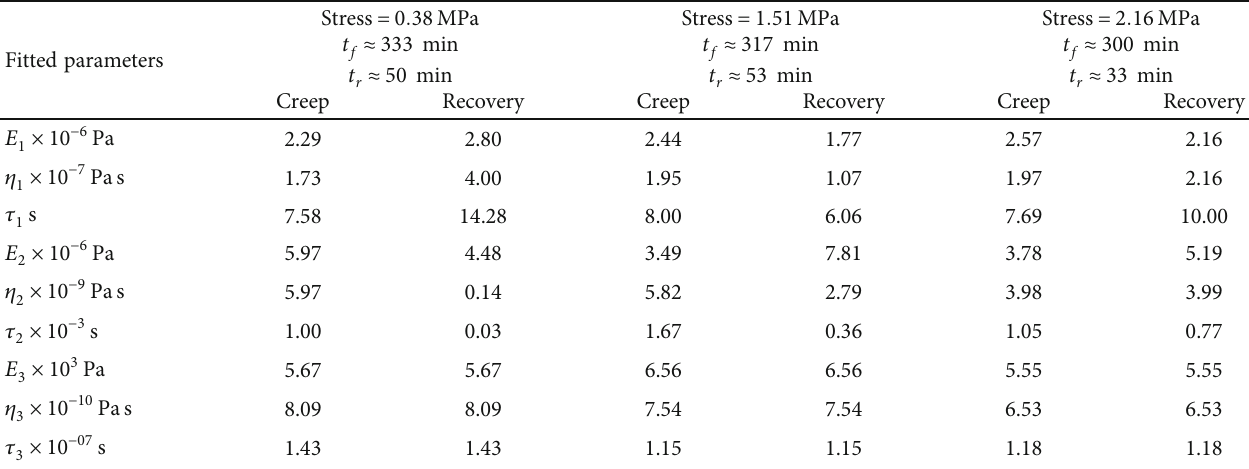
Table 1: Fitted model parameters (for the creep and the recovery) of the material for di ff erent stresses and creep times. Fitted